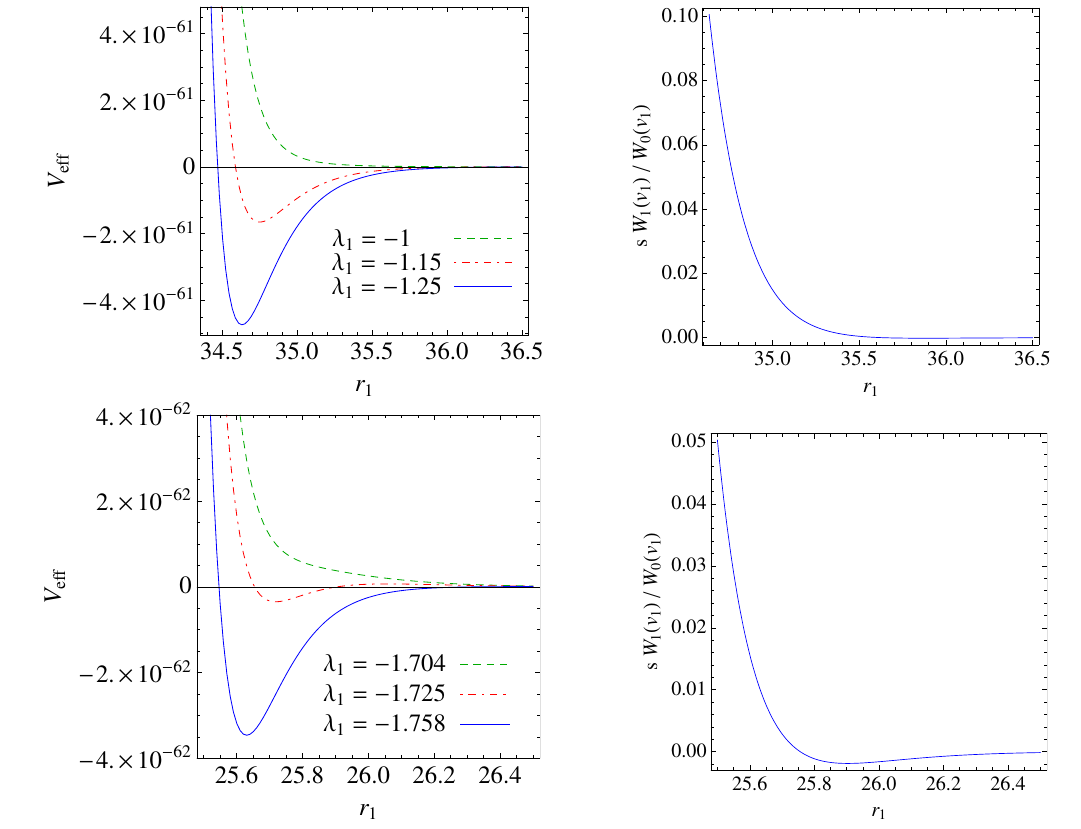
Figure 1 . Left panels: e(cid:11)ective potential for di(cid:11)erent values of (cid:21) 1 in units of ‘ . Only the rel- evant regime r 1 > h r 1 i is considered. Right panels: the relative correction to the superpotential sW 1 ( v 1 ) =W 0 ( v 1 ) as a function of r 1 . The panels on the top correspond to ‘small back-reaction scenario (class A)’, while the panels on the bottom correspond to ‘large back-reaction scenario (class